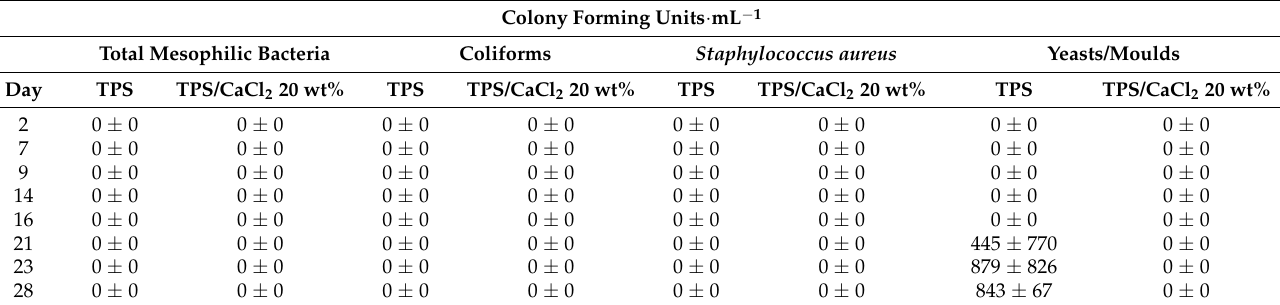
Table 3. Effect of calcium chloride extracted from eggshell on preventing the microbial colonization on fresh-cut apple slices incubated at 20 ◦ C.